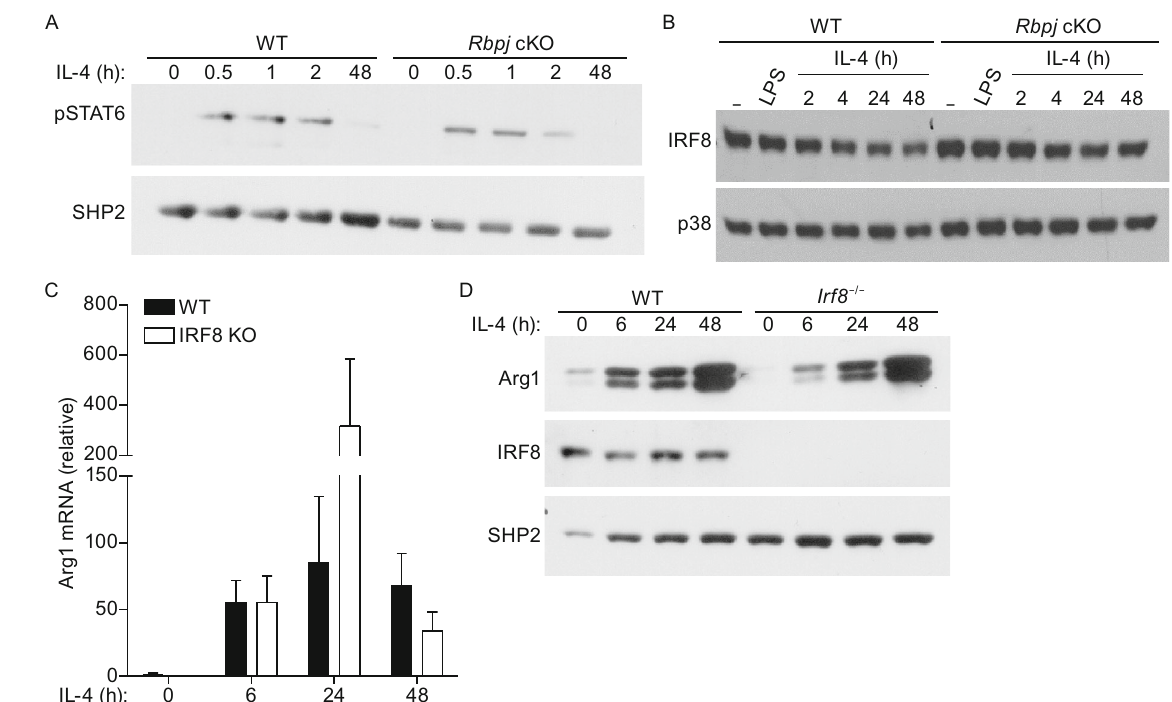
Figure 5. RBP-J regulates Arg1 expression in macrophages independently of STAT6 and IRF8. (A) BMDMs from WTand Rbpj cKO mice were stimulated with 100 ng/mL of IL-4 for the indicated times. Whole cell lysates were analyzed with immunoblotting using antibodies recognizing STAT6 phosphorylated on Tyr641 (pSTAT6). Levels of SHP2 served as loading controls. Results are representative of three independent experiments. (B) BMDMs from WTand Rbpj cKO mice were stimulated with 10 ng/mL of IL-4 and 1 ng/mL of LPS for the indicated times. Whole cell lysates were analyzed with immunoblotting using antibody recognizing IRF8. Levels of p38 served as loading controls. Results are representative of three independent experiments. (C) mRNA expression of Arg1 (relative to GAPDH mRNA) was measured in BMDMs from WT and Irf8 − / − mice. Cumulative results from two independent experiments (errors bars indicate s.d.) are shown. (D) BMDMs from WTand Irf8 − / − mice were stimulated with 10 ng/mL of IL-4 for the indicated times. Whole cell lysates were analyzed with immunoblotting using antibodies against Arg1 and IRF8. Levels of